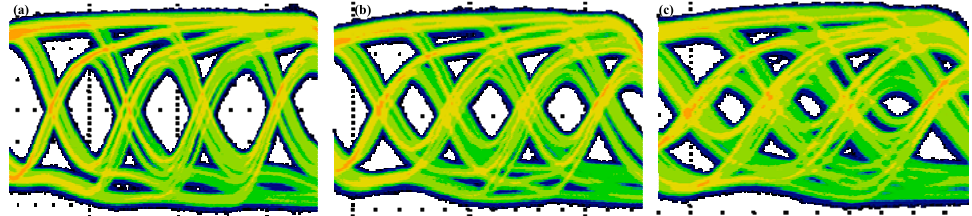
Figure 10. Eye diagrams of received signals at different data rates after TIA circuit. ( a ) 60 Mbps; ( b ) 80 Mbps; ( c ) 100 Mbps.